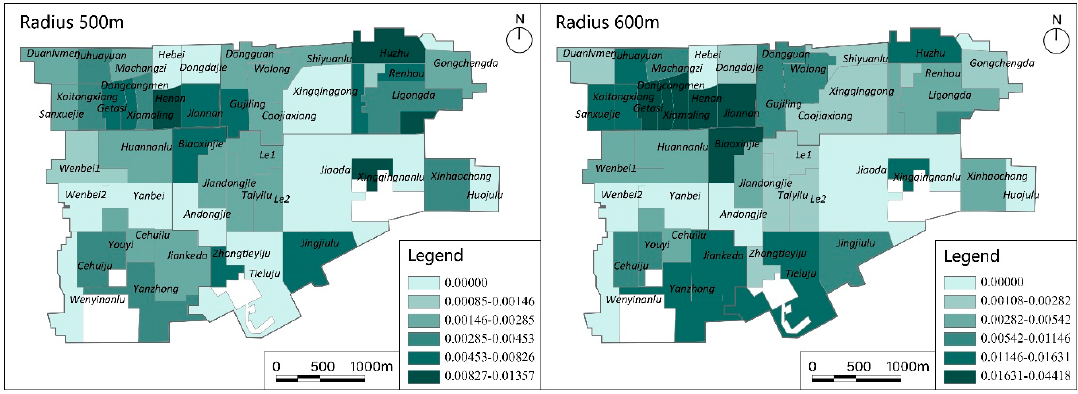
Figure 5. Calculation results of the 2SFCA model with search radii of 500 m ( left ) and 600 m ( right ).